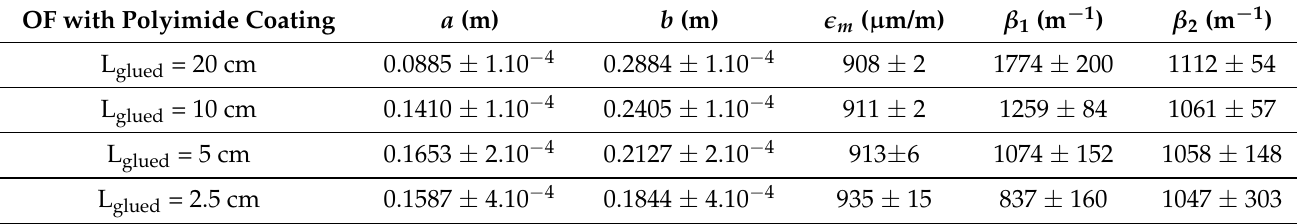
Table 2. Fitting parameters obtained for the sample instrumented by polyimide coated fibers.